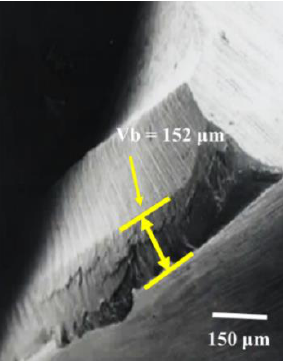
Figure 3. SEM of flank wear (experiment number 1).